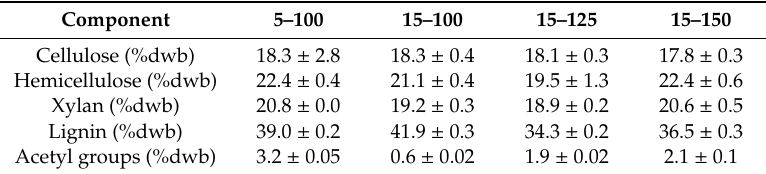
Table 3. Extrudates composition in % dry weight basis (dwb).